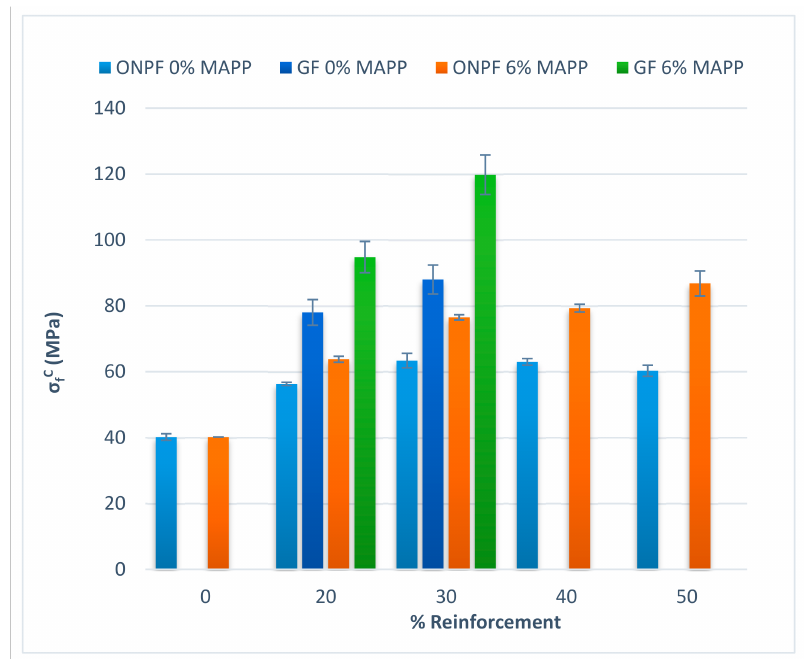
Figure 6. Comparison of the flexural strengths of coupled and uncoupled ONPF and GF reinforced PP